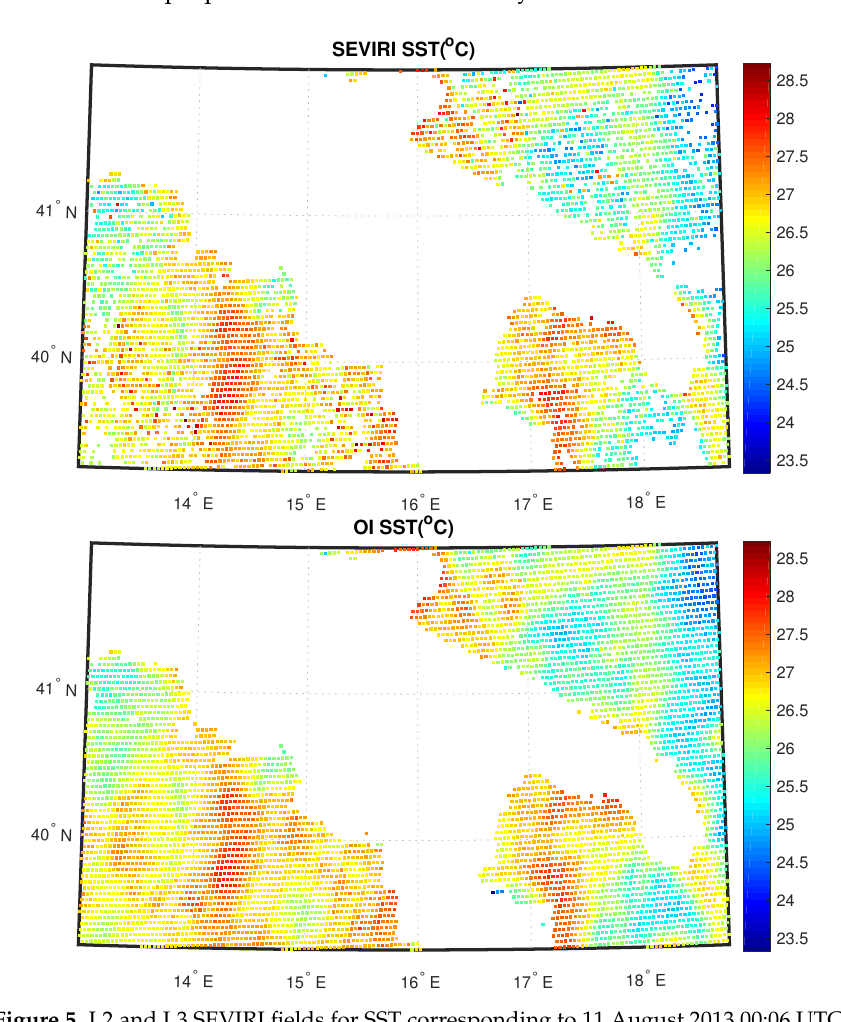
Figure 5. L2 and L3 SEVIRI fields for SST corresponding to 11 August 2013 00:06